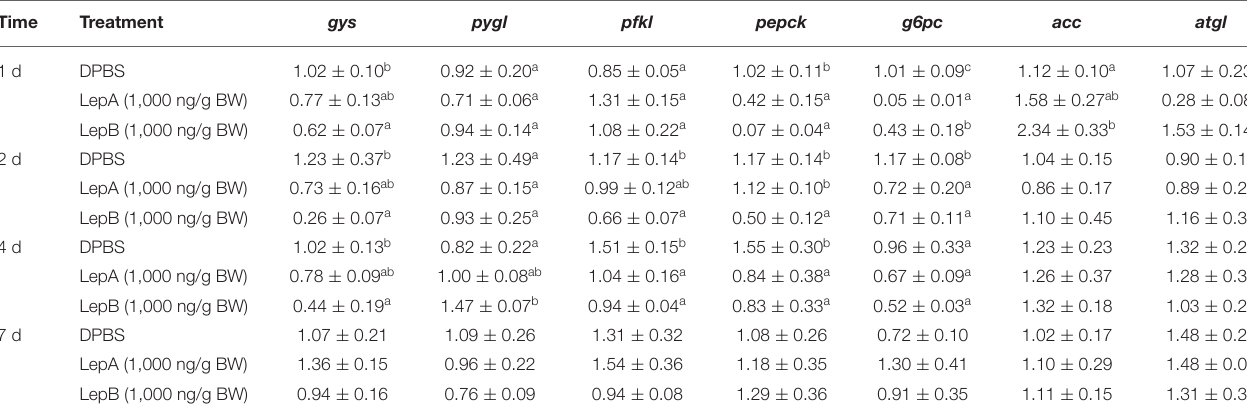
Data represent means ± S.E.M (n = 4). Significance level are marked with different letters (P < 0.05), compared with the values from DPBS injected mandarin fish (P <